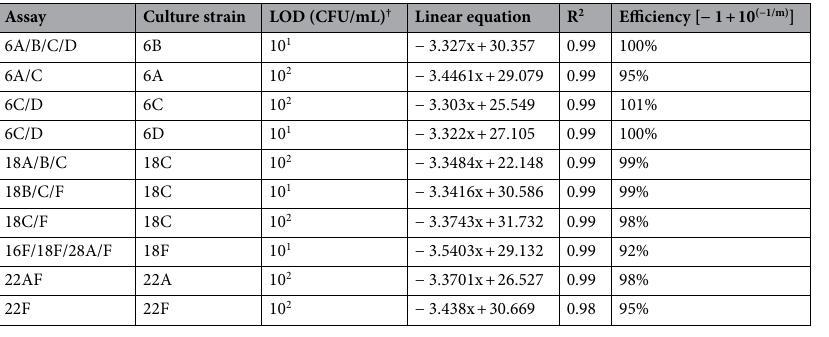
Table 1. Performance of serogroup 6, 18 and 22 assay-sets in the Fluidigm. † All LOD calculations were based on triplicate dilutions of g-Blocks, except for assays 6A/C and 18C/F where relevant culture controls were